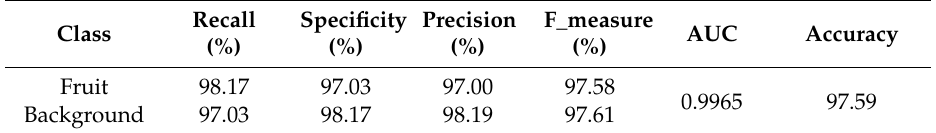
Table 7. The performance of the hybrid ANN-BBO classifier based on di ff erent criteria in the best state of training for the testing data.